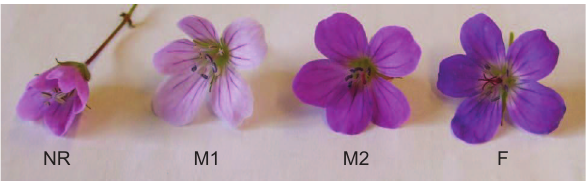
Figure 1. The floral phases in hermaphrodite G. sylvaticum flowers. NR = Non-receptive phase, MI = Male I phase, MII = Male II phase, F= Female phase. See Materials and methods for more details. Flowers were collected from different plant individuals, and therefore show differences in coloration.